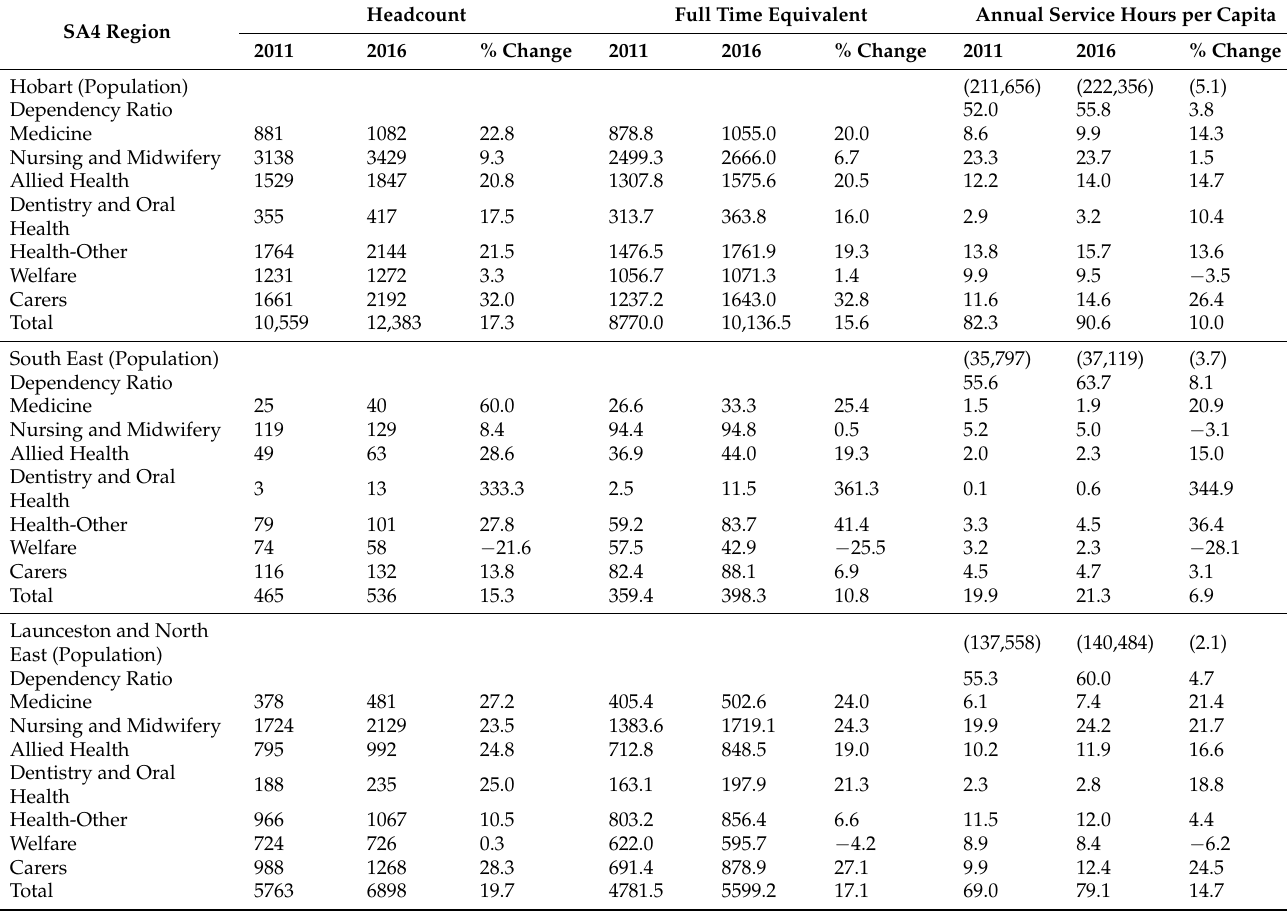
Table 2. Changes in the regional distribution of the Tasmanian health, welfare and care workforce between 2011 and 2016. SA4